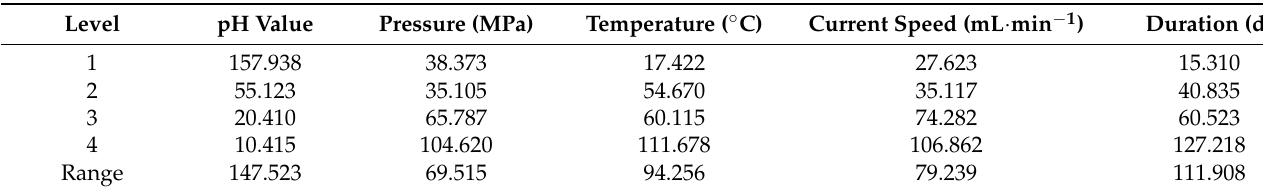
Table 6. Extreme range analysis of dissolution rate of specimens ( mg · g – 1 ).